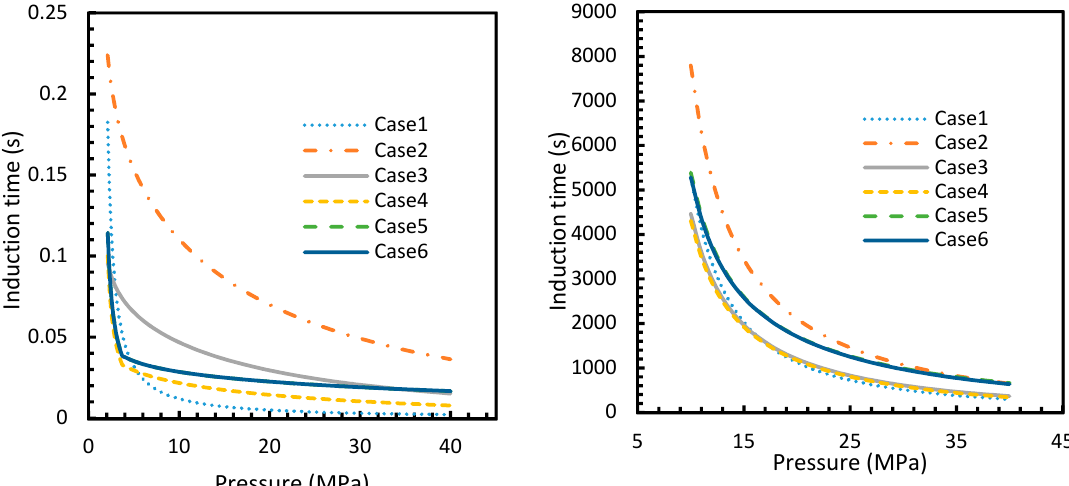
Figure 15. Profiles of equilibrium pressure and bubble point pressure of CO 2 under the operational temperatures considered. The figure clearly shows the point of crossover at 285 K.